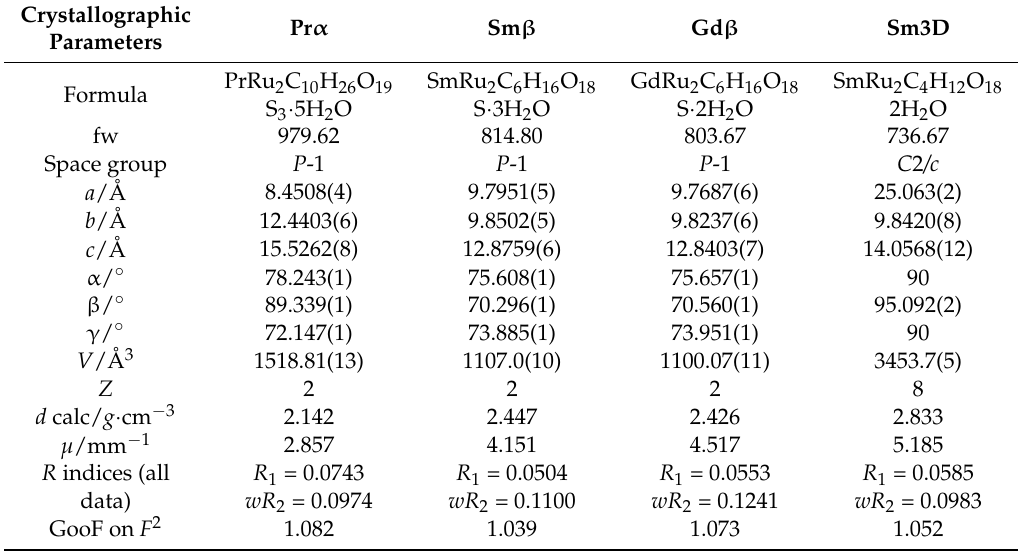
Table 1. Crystal and refinement data for Pr α , Sm β , Gd β and Sm3D